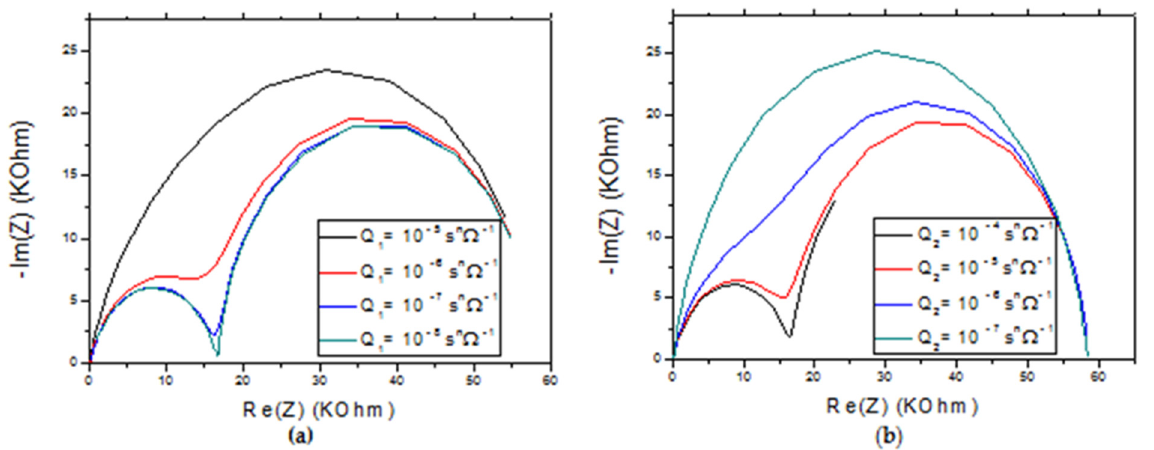
Figure 10. ( a ) Effect of the rate constant Q 1 on the impedance response of CS ‐ MIPs/CMA/Au for Q 2 Q 2 = 10 − 5 s n Ω − 1 . ( b ) Effect of the rate constant Q 2 on the impedance response of CS-MIPs/CMA/Au = 10 − 5 s n Ω − 1 . ( b ) Effect of the rate constant Q 2 on the impedance response of CS ‐ MIPs/CMA/Au for Q 1 = 5 × 10 − 7 . T = 298 K, A = 0.0064 cm², 𝑙 = 60 μ m, k 1 ° = 5 μ m/s, Q 1 = 5 × 10 − 7 s n Ω − 1 , Q 2 = 10 − 5 s n Ω − 1 , n 1 for Q 1 = 5 × 10 − 7 . T = 298 K, A = 0.0064 cm 2 , l = 60 µ m, k 1 ◦ = 5 µ m/s, Q 1 = 5 × 10 − 7 s n Ω − 1 , = 0.8, n 2 = 0.95. [Fe(CN) 6 ] 3 − /4 − = 5 mM. f = 100 KHz–100 mHz. Q 2 = 10 − 5 s n Ω − 1 , n 1 = 0.8, n 2 = 0.95. [Fe(CN) 6 ] 3 − /4 − = 5 mM. f = 100 KHz–100